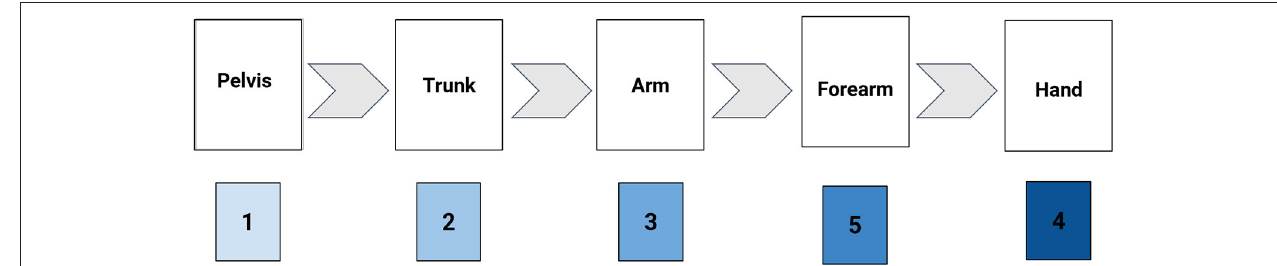
FIGURE 2 | Illustration of the method of Kinematic Sequence naming convention (KS: 12354).